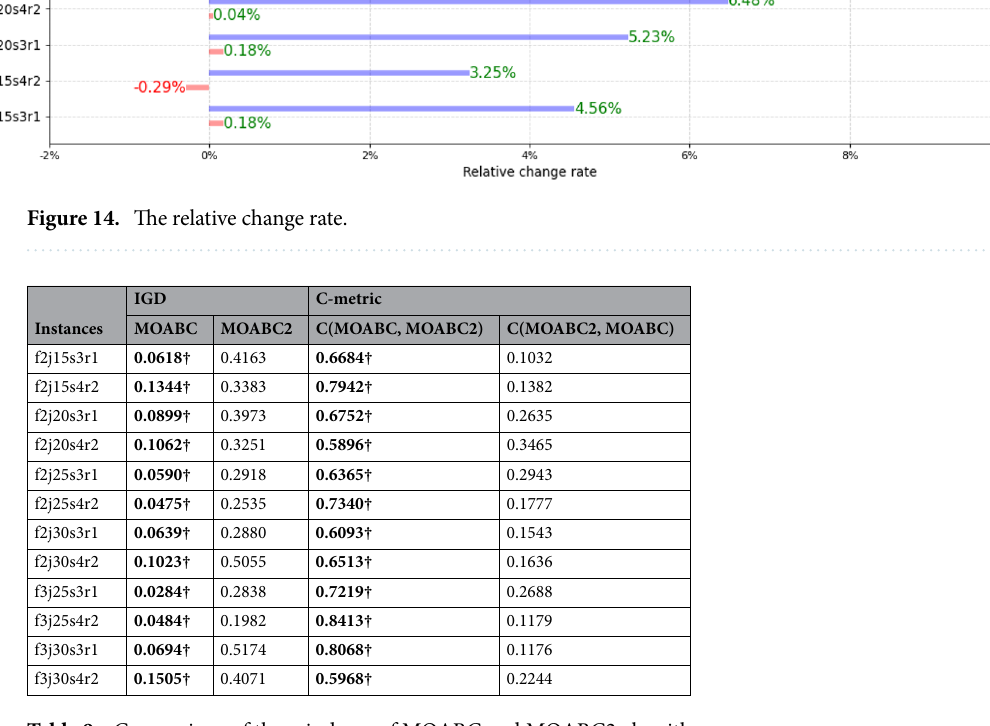
Table 9. Comparison of three indexes of MOABC and MOABC2